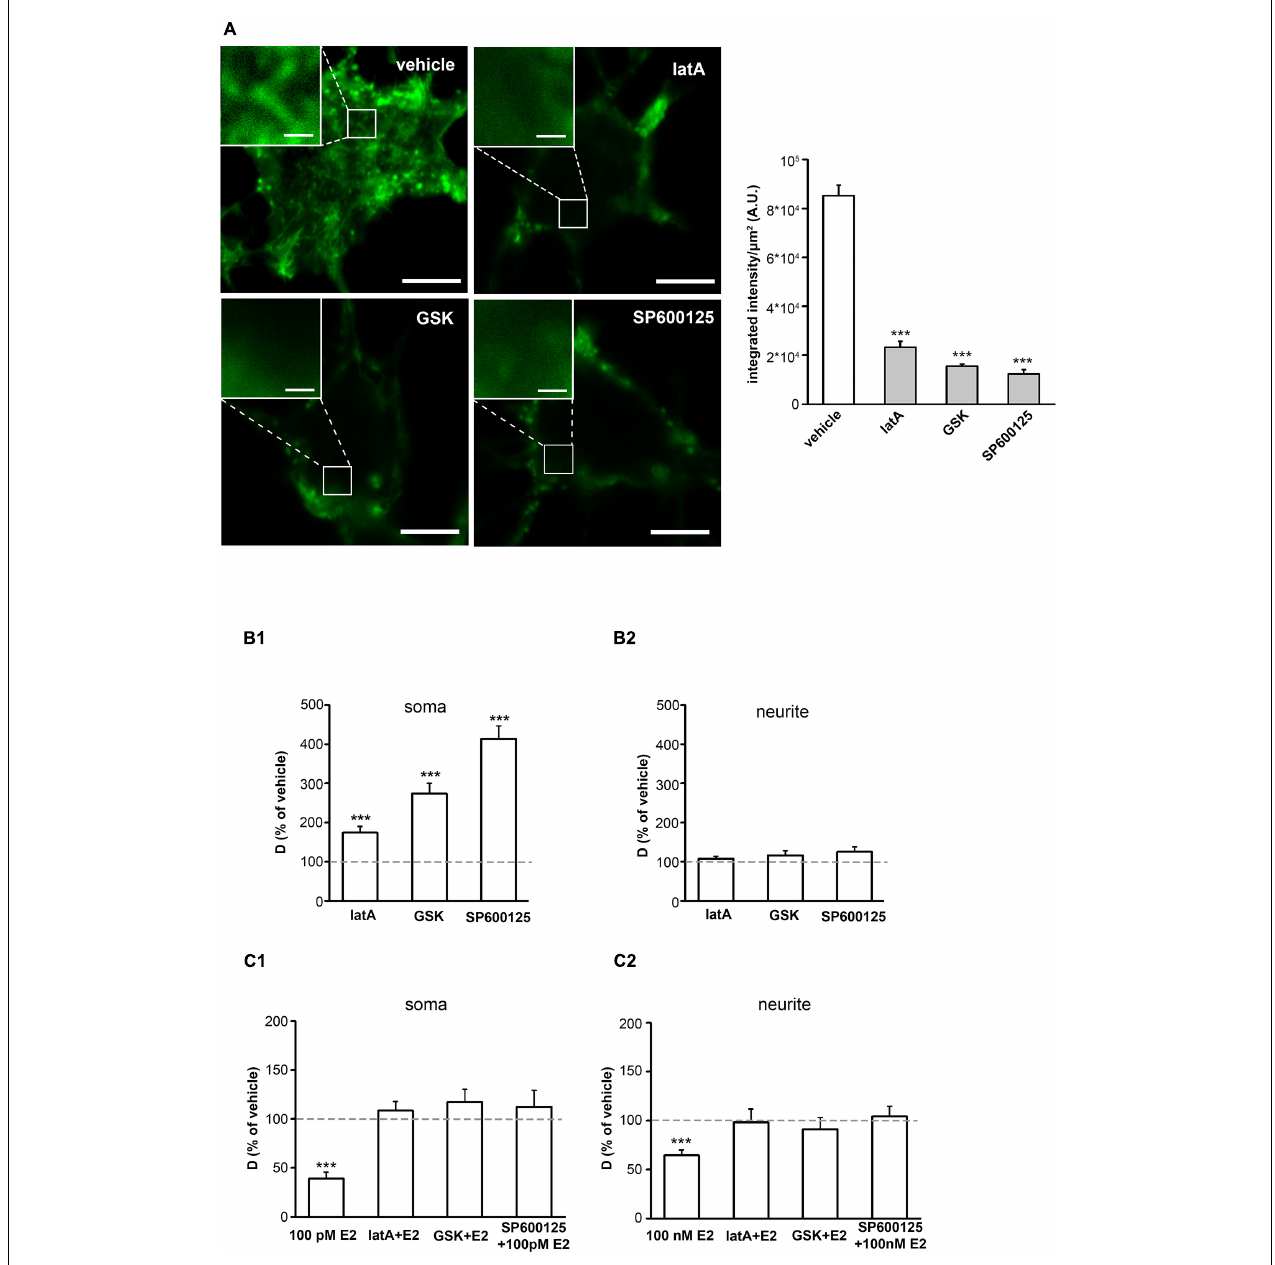
FIGURE 5 | The role of the cortical actin in the rapid effect of E2. (A) Left, confocal images depict Alexa Fluor 488 phalloidin-labeled cortical actin network in dPC12 after treatment with vehicle, 1 µ M of latA, 1 µ M of SP600125 or 1 µ M of GSK429286. Scale bar = 5 µ m; insert Scale bar = 0.5 µ m. Right, the bar graph shows the effect of LatA, GSK429286, and SP600125 on the integrated density of the fluorescently labeled cortical actin network [ n = 3 cells per group (3 ROIs per cell)]. (B1,B2) Effect of LatA, GSK429286, and SP600125 treatment on D AMPAR (% of vehicle treatment as the mean ± SEM; n = 215–544 trajectories). (C1,C2) Effect of 100 pM of E2 on somas and 100 nM of E2 on neurites with or without LatA, GSK429286, and SP600125 (% of vehicle treatment as the mean ± SEM; n = 184–277 trajectories). *** p < 0.001.